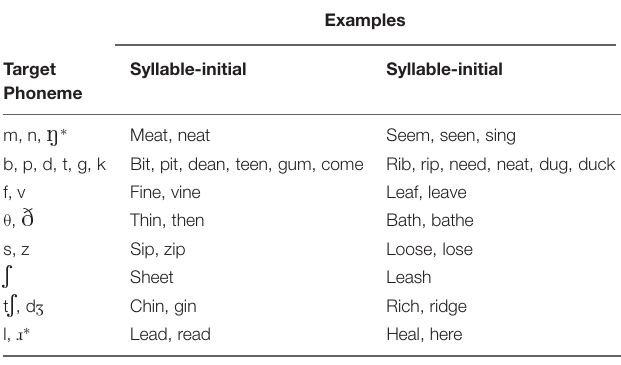
TABLE 1 | Sample words used in the